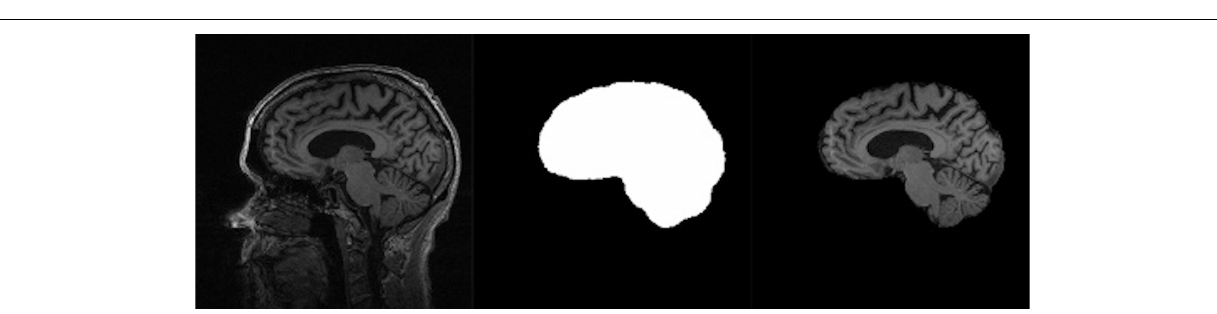
FIGURE 2 | Stages in extraction of ICC from whole head volume. Left panel: whole head MRI. Middle: ICC mask. Right: Resulting ICC volume image. Note the ICC boundary extending beyond the cortical edge to the dura mater boundary. Figure modified from Fletcher and Knaack